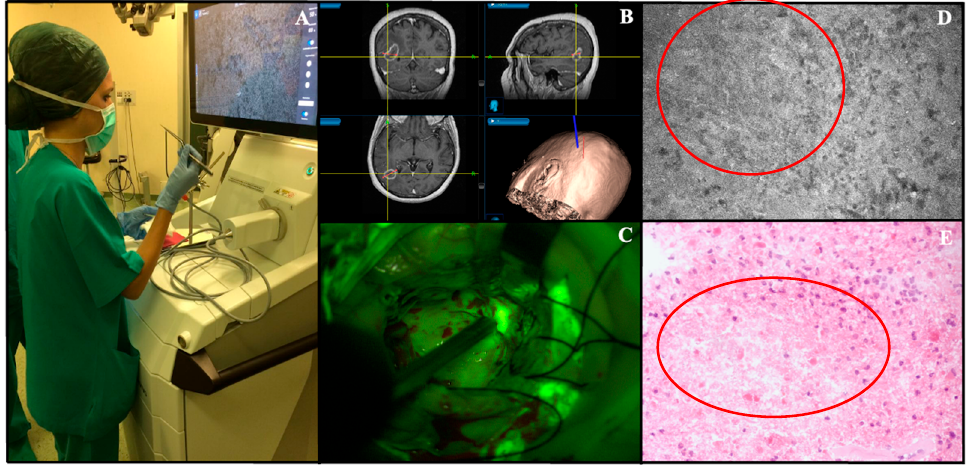
Figure 3. Ex vivo Convivo case (Besta Neurological Institute, Milan, Italy). ( A ). The Convivo station is placed inside OR and confocal imaging analysis is performed ex vivo during surgical operation. ( B ). Preoperative magnetic resonance with contrast administration images loaded on the neuronavigation system (Stealth S8-Medtronic) of a right parieto-occipital GBM. ( C ). Intraoperative view of fluorescein-guided removal of the tumor under YELLOW560 filter activation on Pentero micro-scope (Carl Zeiss Meditec). ( D ). Convivo ex vivo image taken at the center of the tumor showing sparse tumor cells among focal necrosis foci, characterized in CLE images as areas of low cellular density (red circle); the same morphological characteristic may be appreciated in corre- sponding histopathological H-E image (red circle, ( E )).